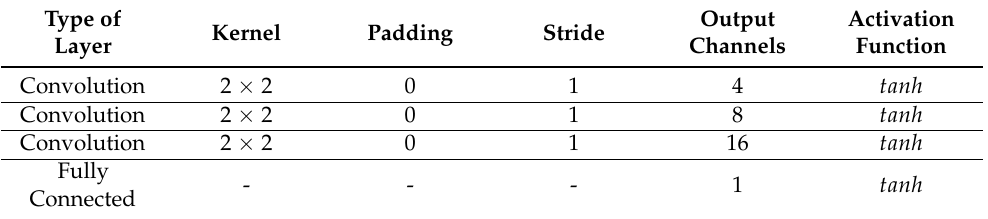
Table 2. CNN architecture. The input consisted of the 16 previous measurements arranged in a 4 × 4 lattice with one channel. Regularizers were not required due to the kernel sizes and the NN size